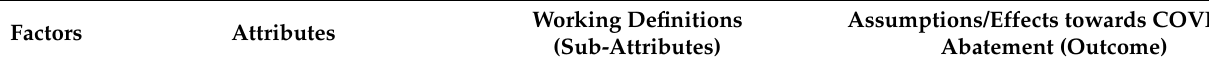
Table 2. An operational framework comprising list of attributes, its working definitions, and effects towards COVID- 19